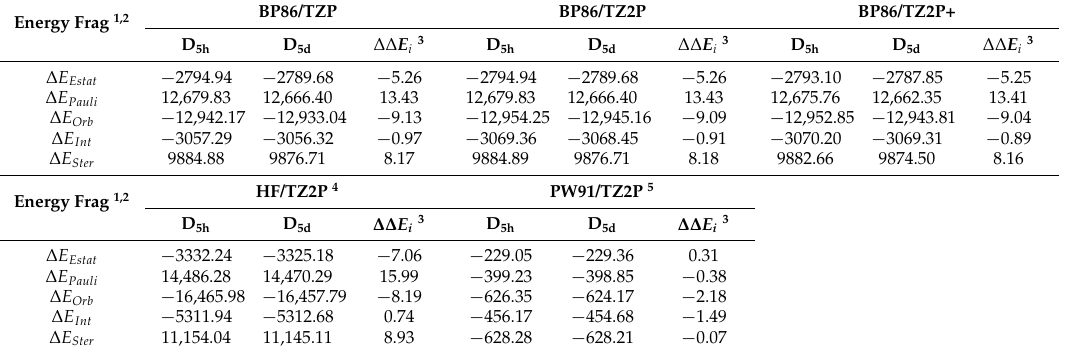
Table 2. Comparison of energy terms for the eclipsed (D 5h ) and staggered (D 5d ) ferrocene using